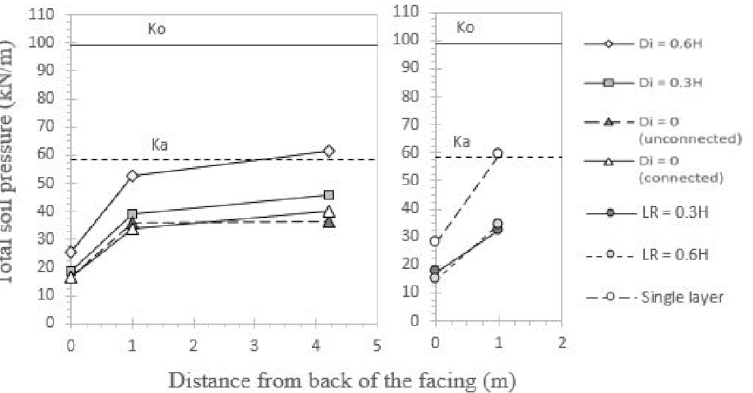
Figure 15. Total earth pressure at the facing, at 1 m from the facing, and behind the reinforcements (i.e., at L -distance from the facing) at the end of construction (EoC) for different interaction distances ( D i ) between back-to-back reinforced soil